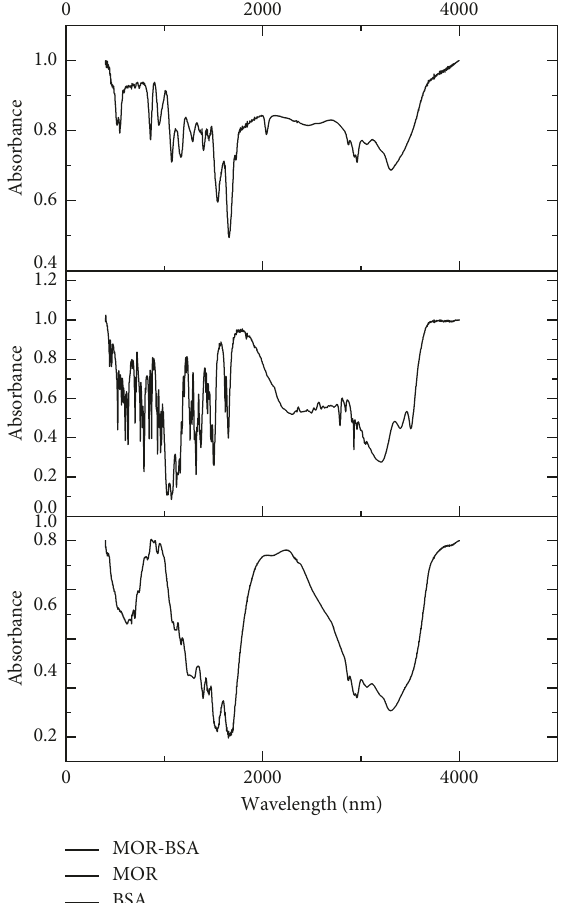
Figure 3: IR spectrum of MOR